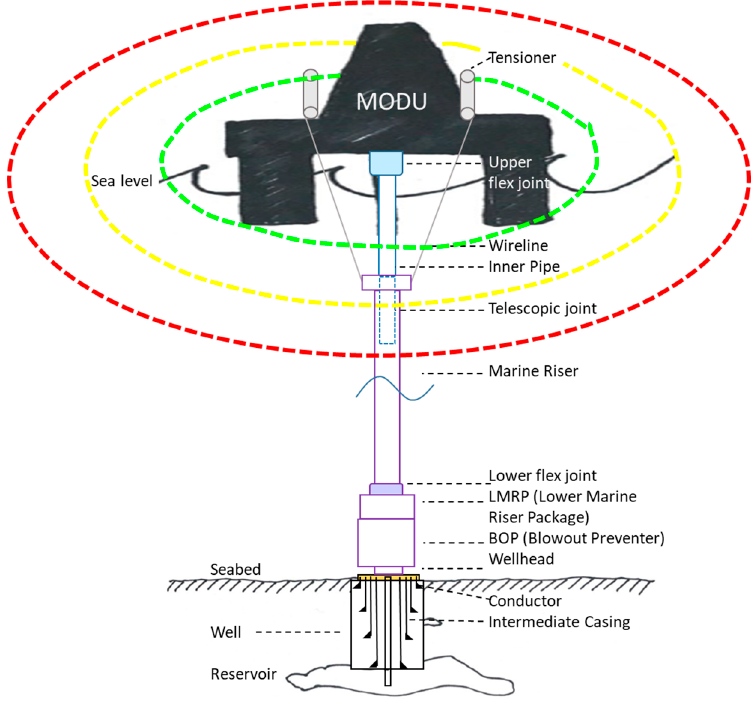
Figure 1. Rig connected to the well by marine riser string elements. Not to scale. Green dotted circle indicates safe operating area and red dotted circle the limits where EQD is needed. (Source: Authors).